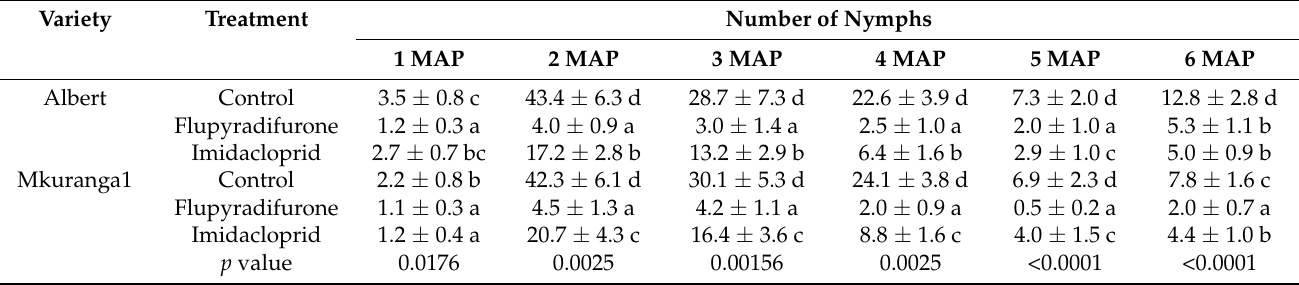
Table 6. Whitefly nymph abundance for cutting dipping method, 2020 (Means ± SE) Z